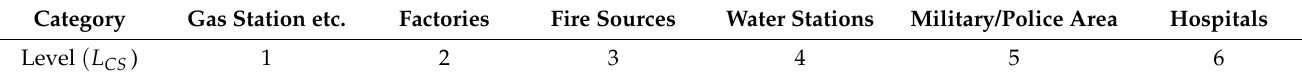
Table 11. Customer social significance